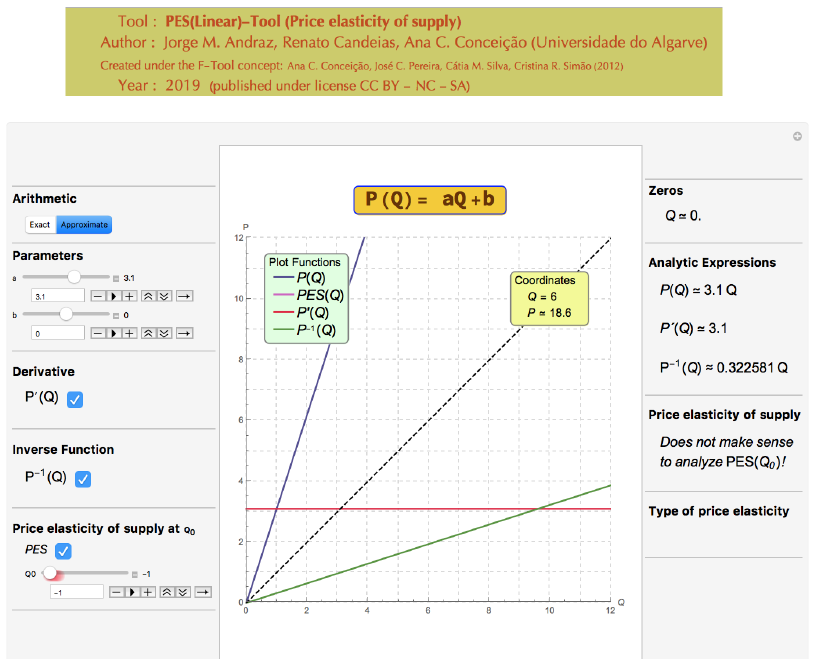
(cid:17) (cid:16) − b ,0 (if any positive a